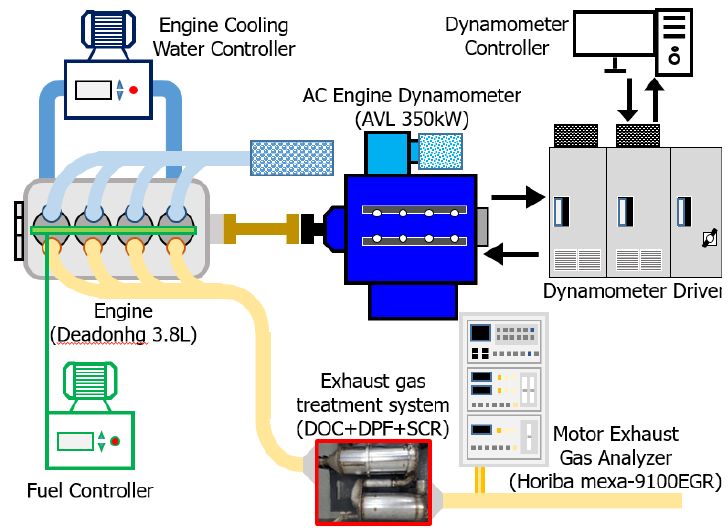
Figure 3. Schematic diagram of the engine dynamometer apparatus.